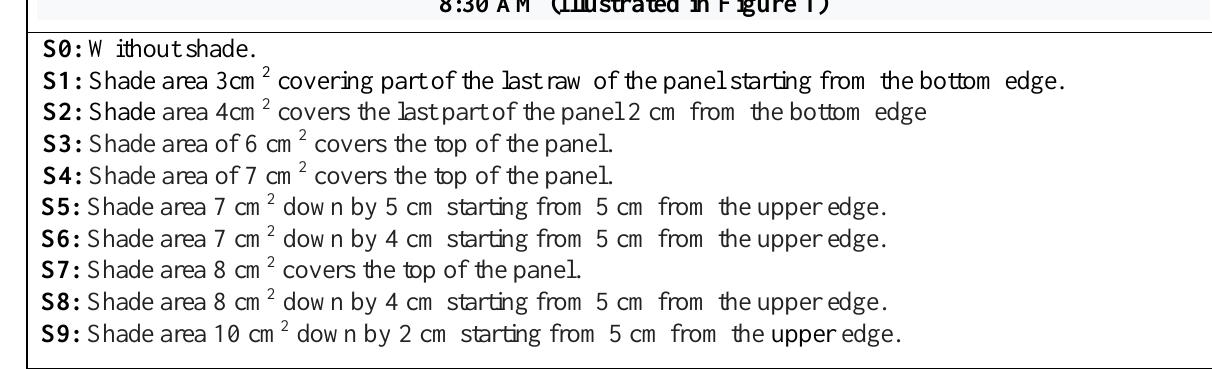
Table 1. Nomenclature of the shades cases. 8:30 AM (Illustrated in Figure